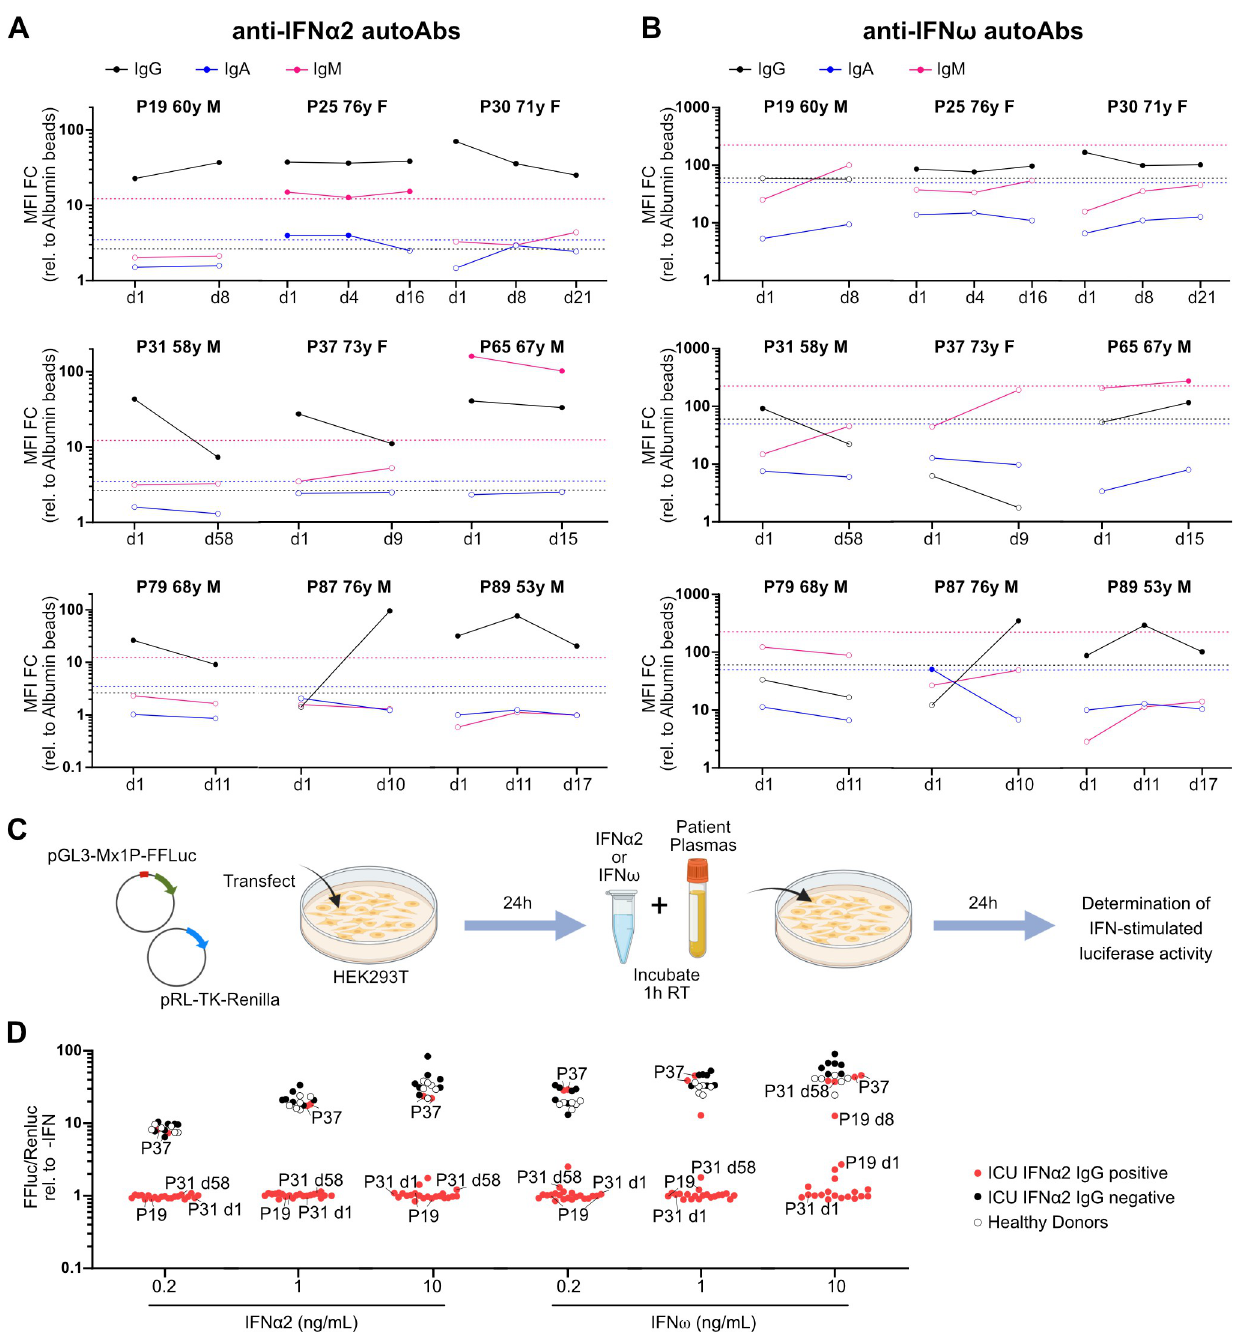
Fig 2. Longitudinal analysis of plasma autoantibodies targeting type I IFNs in individual critically ill COVID-19 patients and their neutralization capacities. (A and B) Longitudinal analysis of plasma anti-IFN α 2 (A) and anti-IFN ω (B) IgG, IgA, and IgM autoAbs in selected critically ill COVID-19 patients positive for plasma anti-IFN α 2 IgG. Samples were collected on day of admission to ICU (d1) and as indicated thereafter. MFI FC of signal derived from IFN-coated beads relative to the MFI of signal derived from albumin-coated beads is shown. Dashed lines indicate 10 SDs (IFN α 2) or 5 SDs (IFN ω ) from the mean calculated from HD values for each IFN and each isotype in Fig 1A and are used as threshold values for positivity (filled circles). Internal patient identifier numbers (P) are shown, together with the individual’s gender (male, M; female, F) and age (years, y). (C) Schematic representation of the luciferase reporter-based neutralization assay. HEK293T cells are cotransfected with a pGL3-Mx1P-FFLuc reporter (FF-Luc) plasmid and a constitutively active pRL-TK-Renilla (Ren-Luc) plasmid. After 24 h, cells are incubated with IFN α 2 or IFN ω that have been preincubated with patient plasmas. After a further 24 h, cells are lysed, and IFN-stimulated luminescence intensity (FF-Luc) is measured and made relative to the constitutively active Ren-Luc. Schematic created with BioRender.com. (D) Results for the neutralization of 10, 1, or 0.2 ng/mL of IFN α 2 or IFN ω in the presence of 1/50 diluted patient